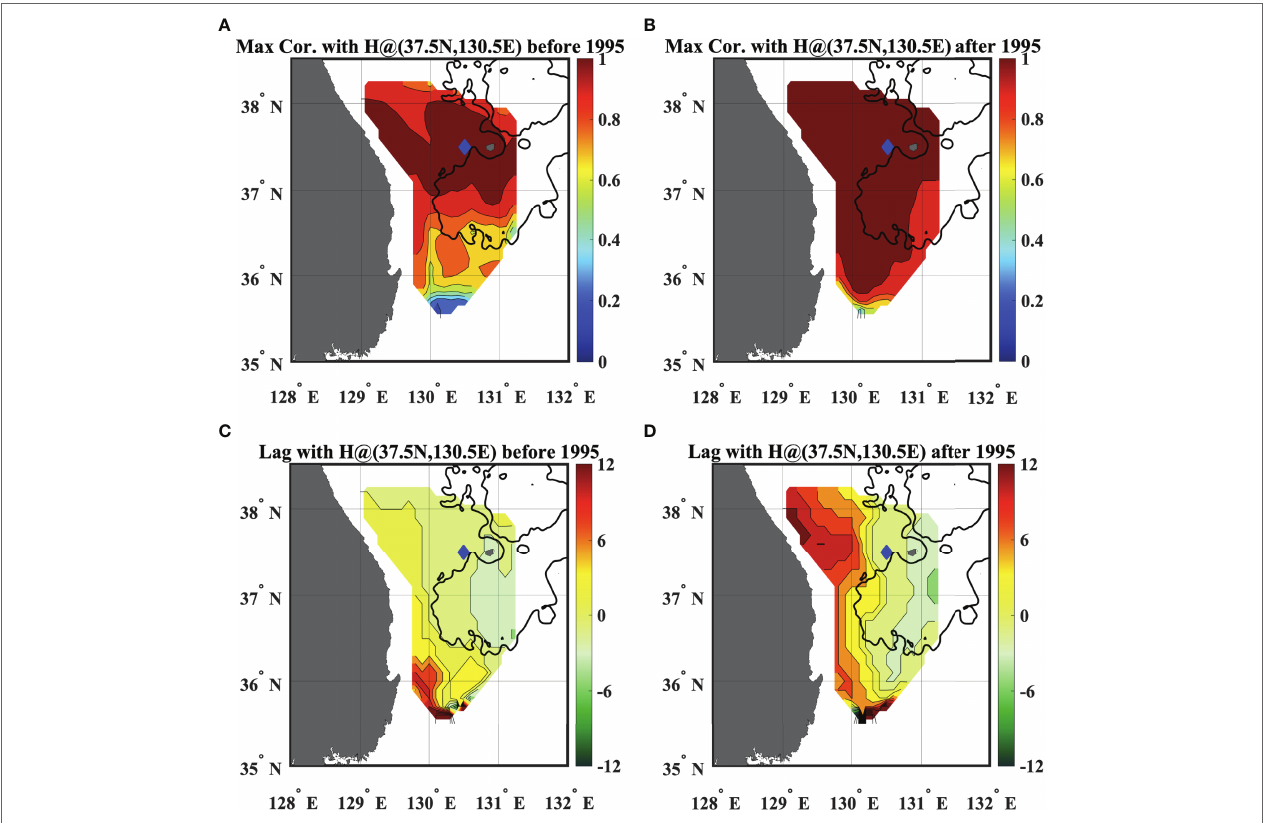
FIGURE 11 | Spatial maximum correlation map of the ESIW thickness with the reference point at 37.5°N 130.5°E (A) from 1965 to 1994 and (B) from 1995 to 2020. Panels (C, D) show the monthly lag where the maximum correlations in (A , B) are, respectively. Blue diamonds denote the reference point. Contour intervals are 0.1 in (A , B) and 2 months in (C, D)